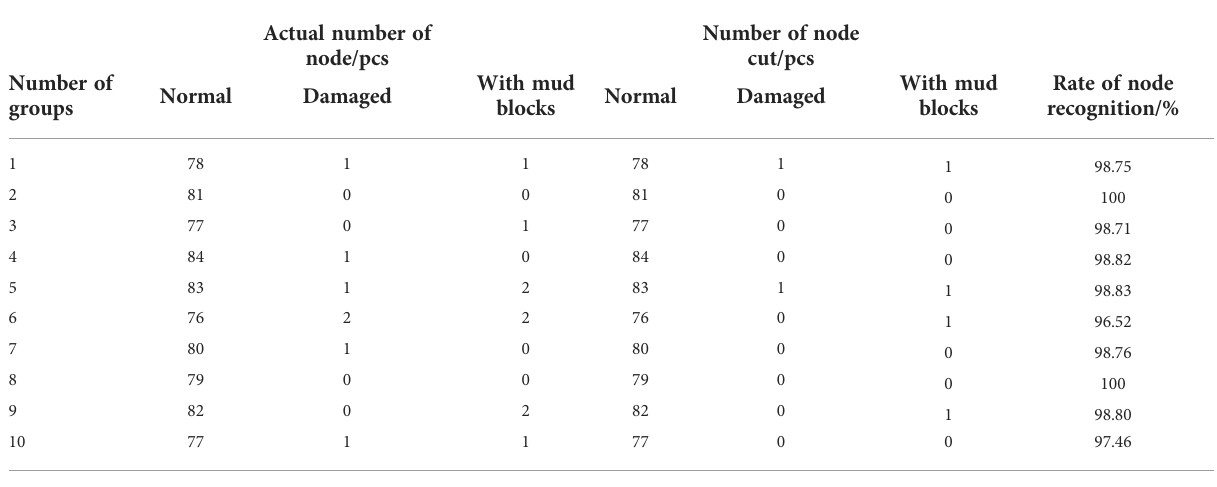
TABLE 3 Cutting